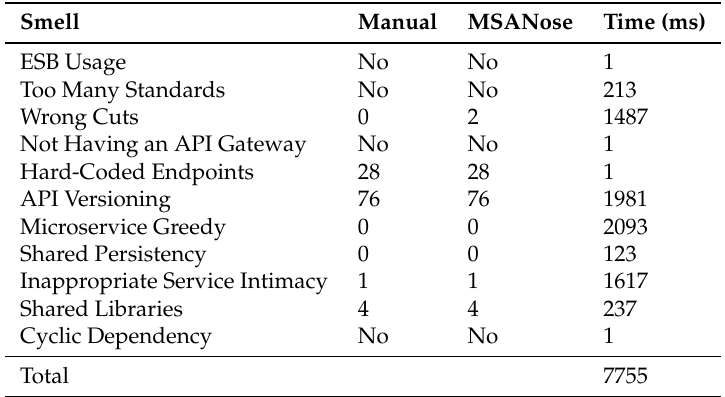
Table 2. Case study in Train Ticket benchmark